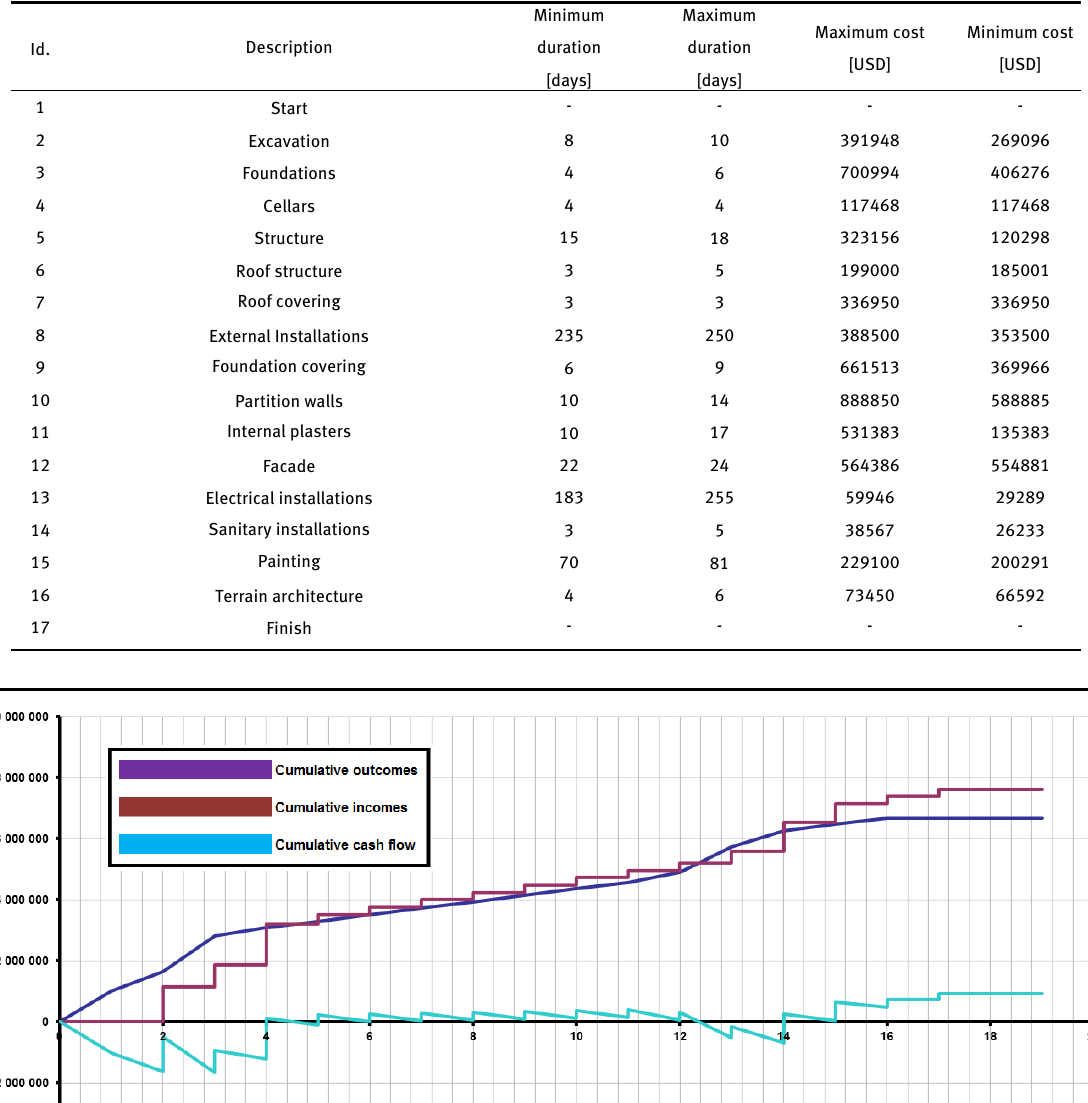
Table 2: The example project schedule data – limited range